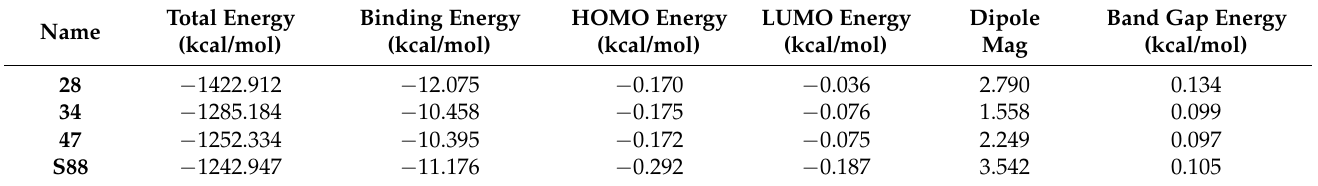
Table 5. Spatial distribution of molecular orbitals for candidates 28 , 34 , 47 and S88